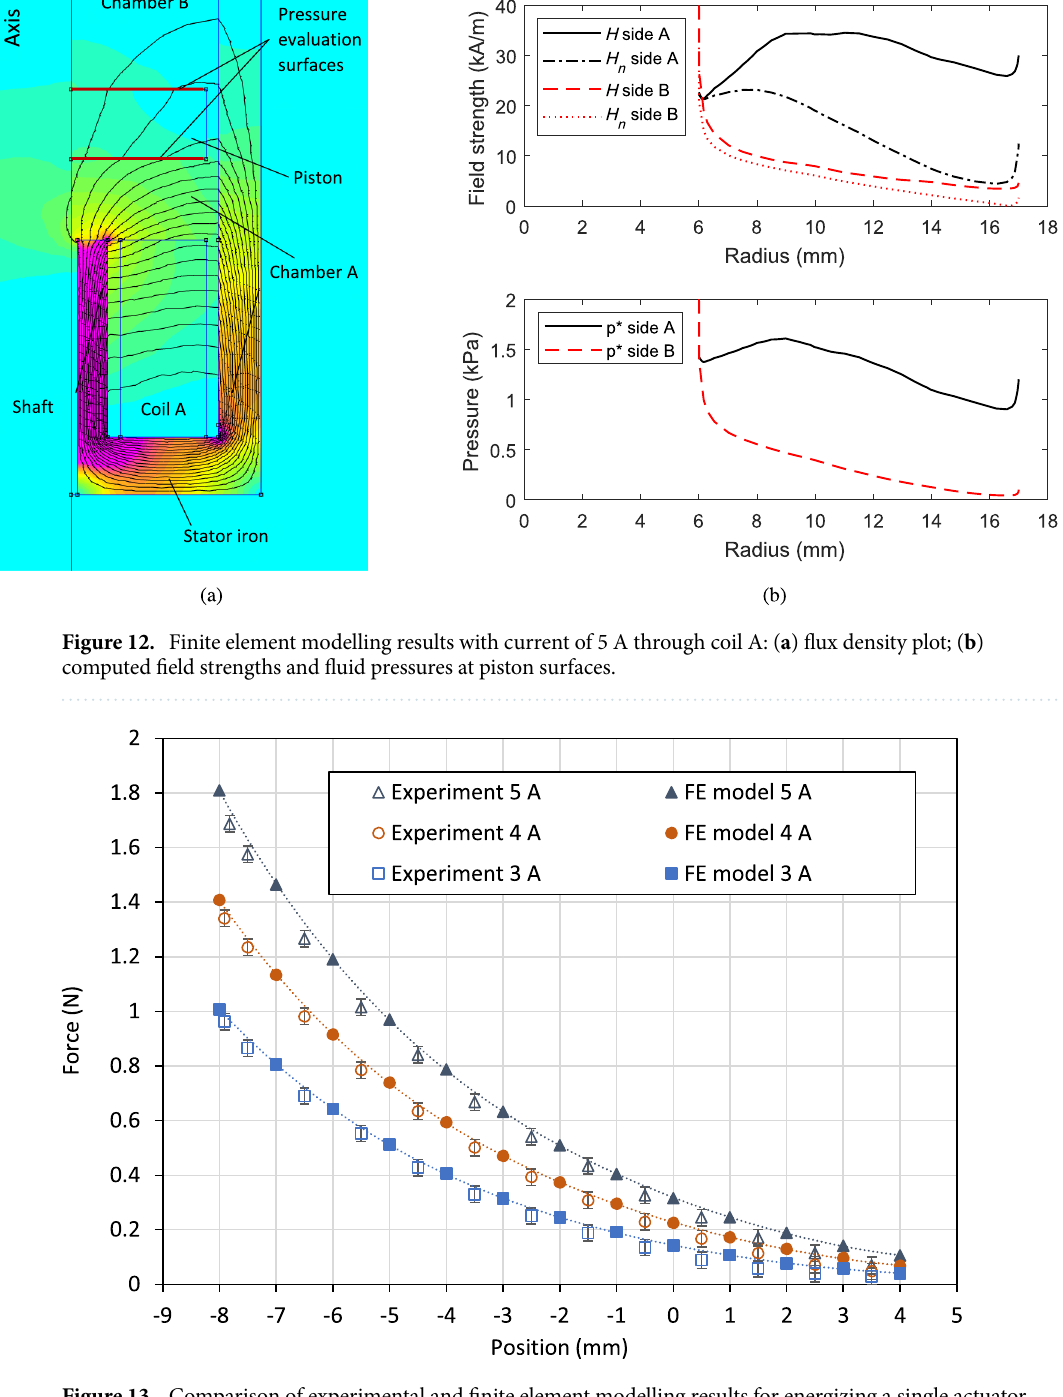
Figure 13. Comparison of experimental and finite element modelling results for energizing a single actuator coil. The static actuation force is shown for different piston positions and coil current